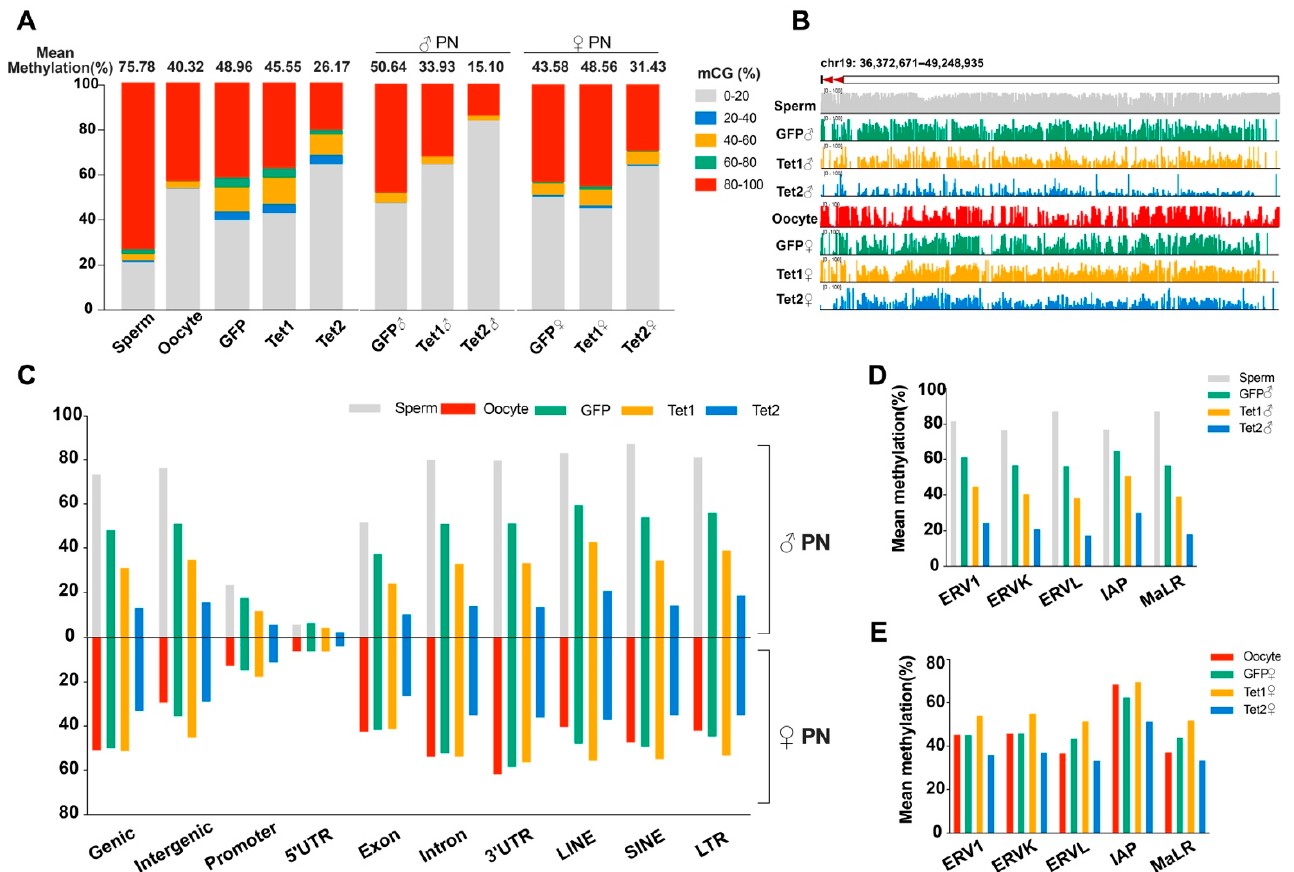
Figure 2. Methylation levels of parental genomes in gametes and zygotes. ( A ) A global view of DNA methylation in each sample. The proportions of 100 bp tiles at five methylation levels are shown. ( B ) Changes in the methylation levels of representative regions obtained using the IGV browser. ( C ) Mean DNA methylation levels of various functional regions and transposon regions. ( D , E ) The paternal and maternal genome methylation levels in subcategories of LTR repeats, respectively.